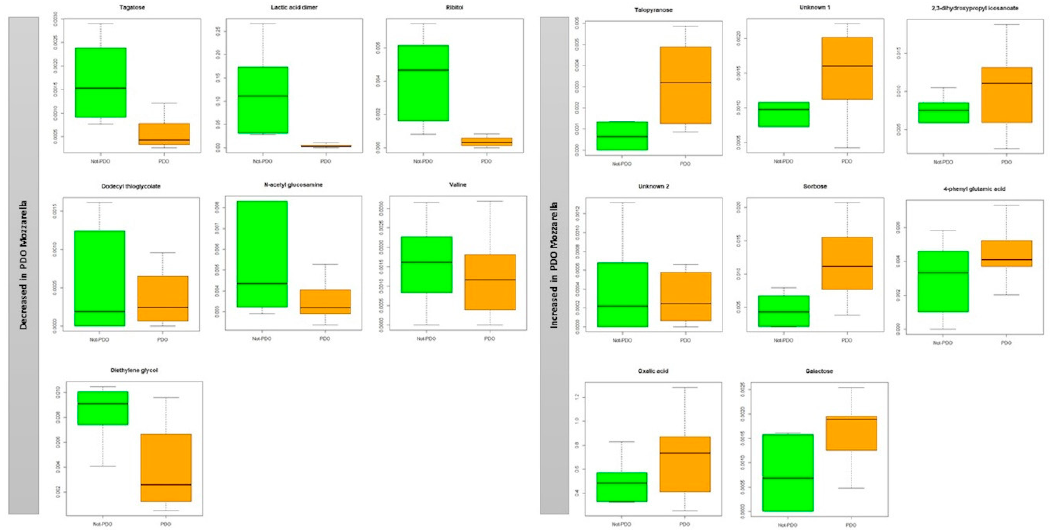
Figure 3. Box and Whisker plot of the VIP metabolites in buffalo mozzarella samples. Boxes represent non-PDO (green) and PDO (orange) mozzarella samples. The vertical axis reports the log of the gas chromatography mass spectrometry values of the normalized area of each metabolite.